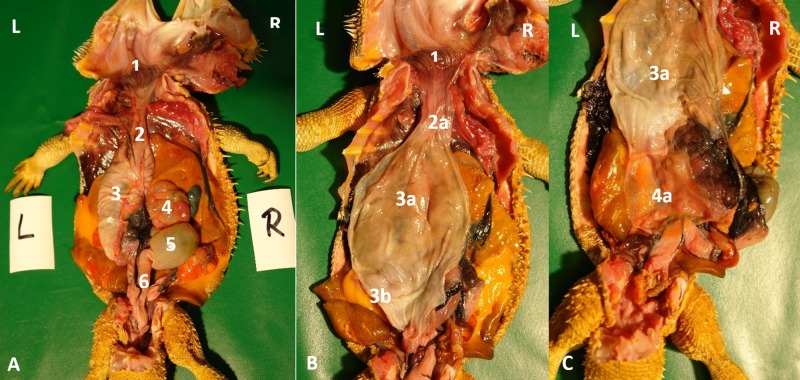
Topography of the alimentary canal of a female bearded dragon, dorsal view.Dorsal skin, muscles, skeleton, and serosa removed; lungs distracted cranially; and dorsal pelvis removed for an in situ view. L: left; R: right. A. Topography in situ: oral cavity and pharynx (1), esophagus (2), stomach (3), small intestine (4), ampulla coli (5), and rectum (6). B. Alimentary canal opened: oral cavity and pharynx (1), esophagus (2a), stomach (3a), and transverse gastric fold caused by angular incision (3b). C. Alimentary canal opened and distracted cranially to demonstrate the pyloric circular fold (3c*); stomach (3a), and duodenum (4a).